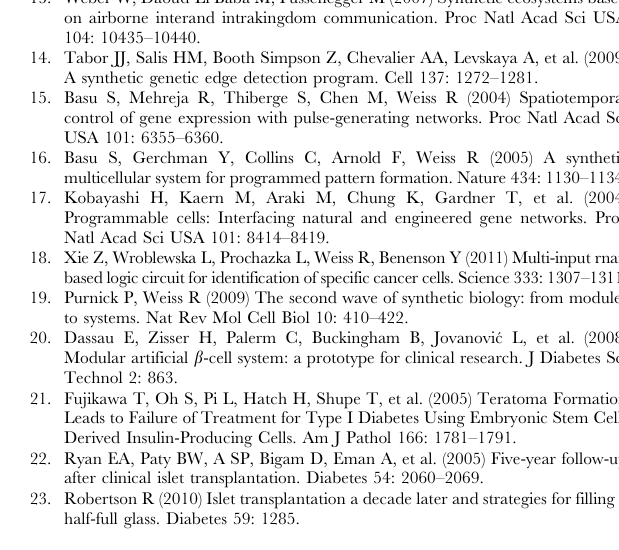
Table S1 Parameters for the Langevin models of Systems 2 to 4. Table S2 Scaled parameters for the time-scale analysis. The kinetics parameters ( k a and k a ) from Table S1 are scaled by p d the time-scale parameters TS a according to their module. For each combination of time-scale parameters, the k a and k a p d parameters are used for the Langevin simulations. Table S3 List of reactions for the full multicellular model of System 3. Depending on whether the reactions are associative or dissociative, reaction rates are in units of (molecules